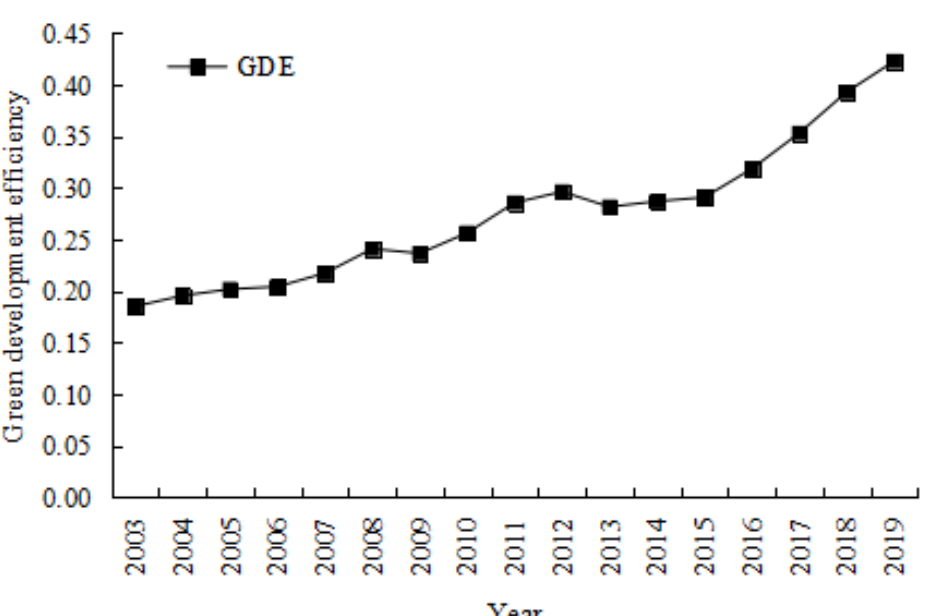
Figure 2. Evolution trend of the green development efficiency in China (2003 – 2019) .